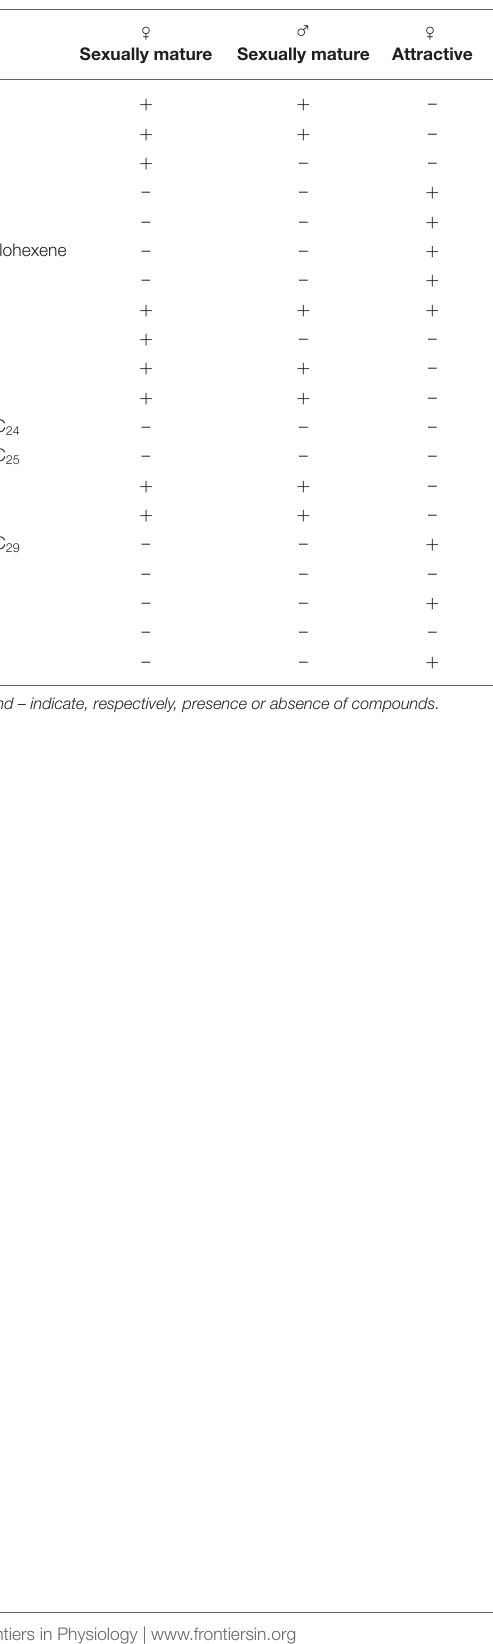
TABLE 2 | Peaks produced by the hexane extracts from the whole bodies of virgin males and females of C. tenebrionis